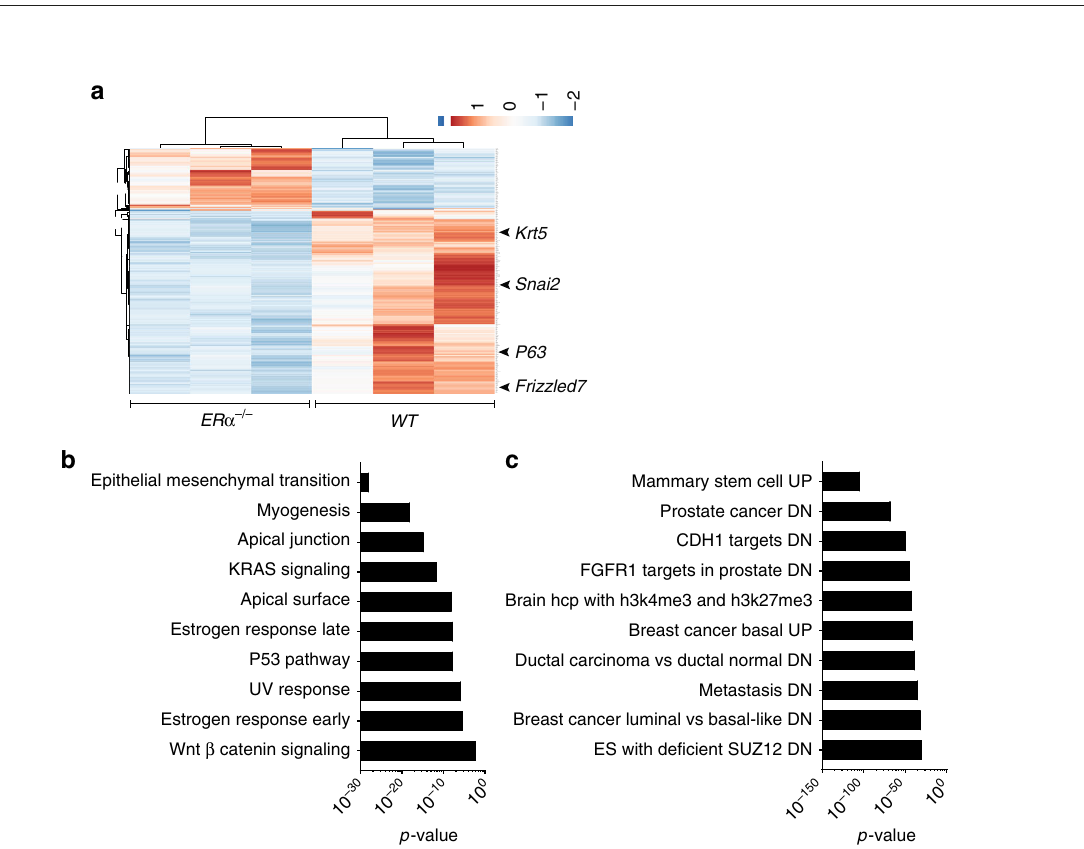
Fig. 7 Global gene expression pro fi le of ER α − / − and WT MECs. a Principal component (PC) analysis of RNAseq data showing the importance of the Esr1 genotype for global gene expression. b Bar graph showing the number of genes whose expression increased (IE) or decreased (DE) in ER α − / − .GFP + vs. WT.GFP + MECs engrafted intraductally to contralateral glands of NSG females and subsequently isolated by FACS-sorting from hosts during pregnancy. c Bar plot showing reads per kilobase million (RPKM) of ER α high, sensor cell markers expressed in ER α − / − .GFP + and WT.GFP + MECs that were engrafted intraductally to contralateral glands of NSG hosts and subsequently isolated by FACS-sorting from pregnant hosts. d Bar plot showing RPKM of milk genes expressed in FACS-sorted ER α − / − .GFP + and WT.GFP + MECs grafted intraductally and isolated from pregnant hosts. e, f MetaCore analysis of